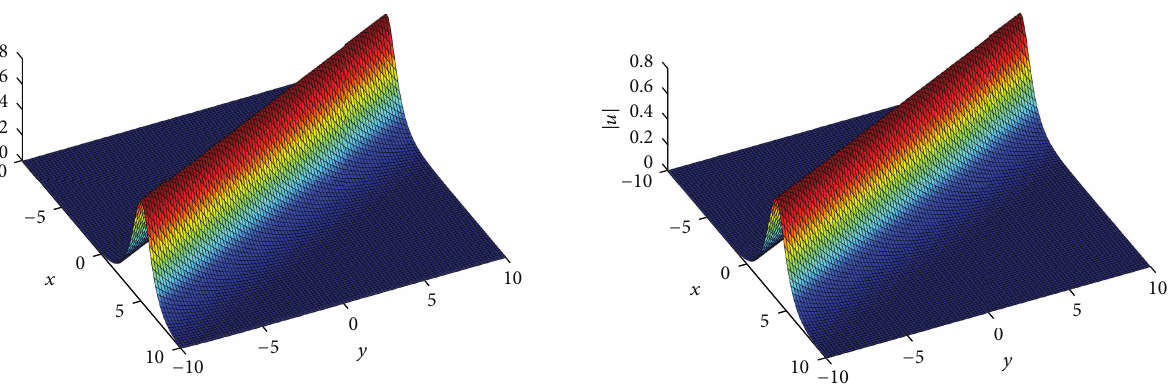
Figure 1: Single soliton 𝛽 1 = 𝜅 1 = 0.5 , 𝛽 2 = 𝜅 2 = 1 , 𝛼 = 1 , 𝑡 = 0 . Figure 2: Single soliton 𝛽